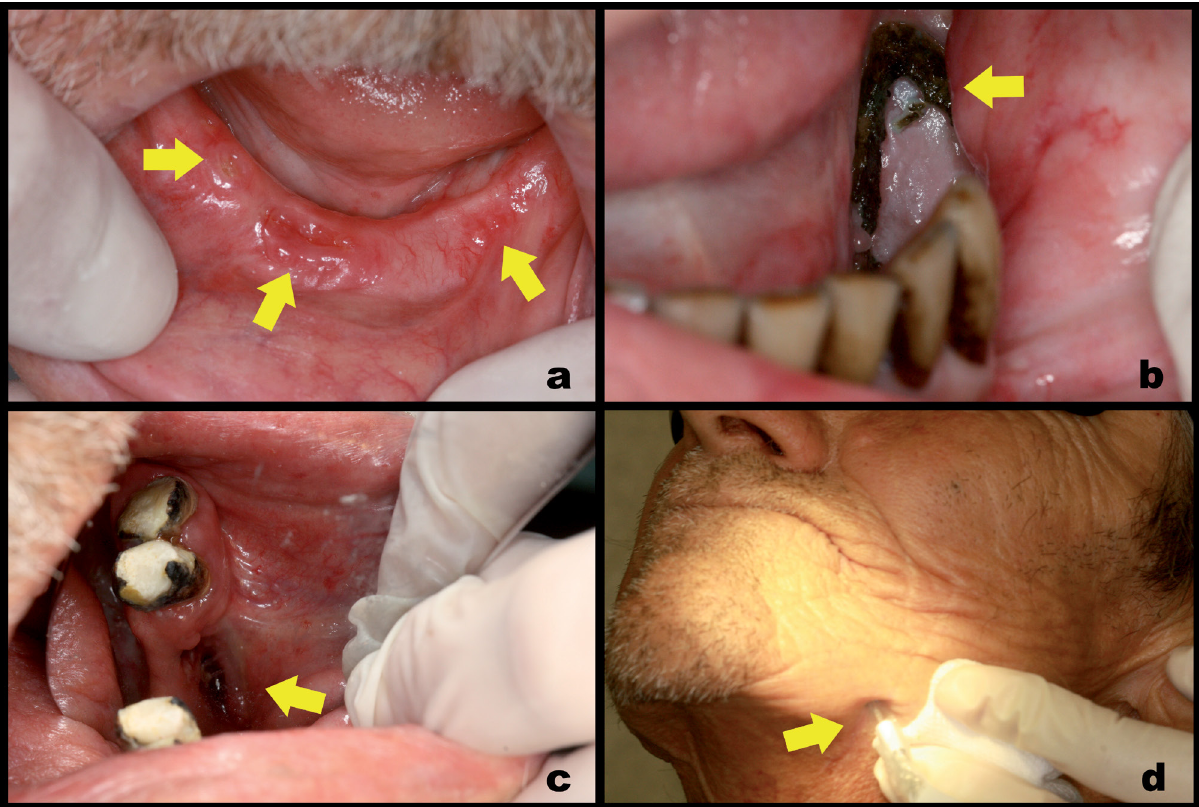
Figure 3- Patients with ORNJ. Stage I: bone exposures < 2 cm, asymptomatic, without evidence of infection (a). Stage II: bone exposure ≥2 cm, symptomatic, with infection, erythema and pain (b). Stage III: orocutaneous fistula with purulent drainage in intraoral (c) and extraoral (d)